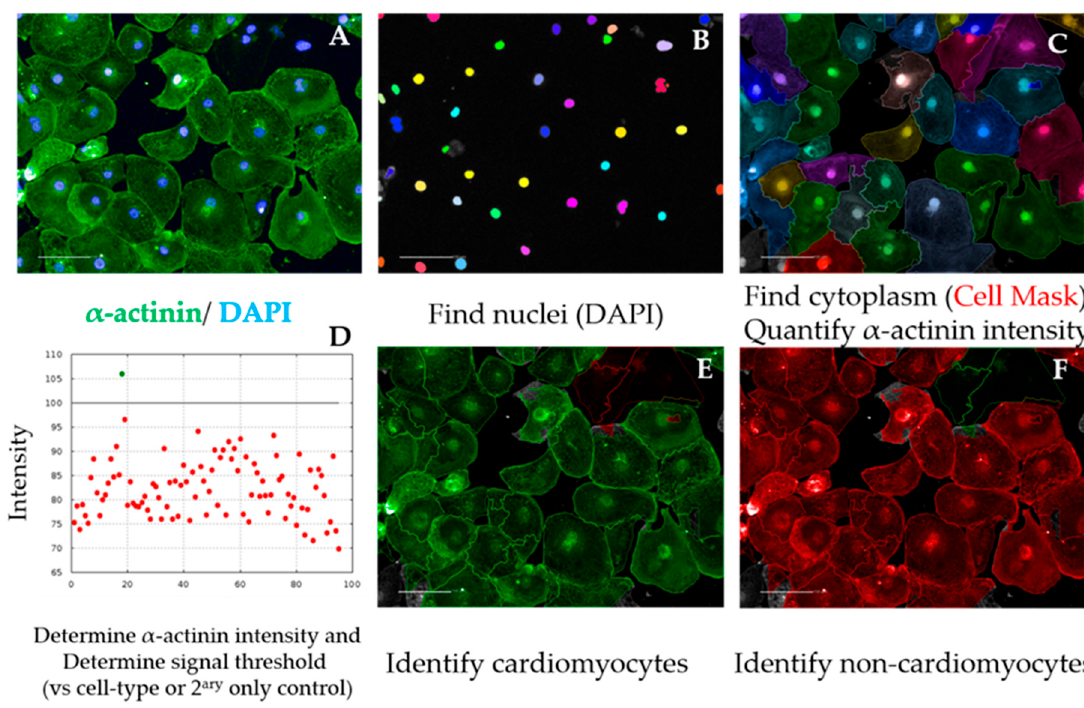
Figure 4. Cardiomyocyte purity analysis sequence. Representative micrographs of image analysis of hPSC-CMs. After inputting the image ( A ), the software excludes debris and cell clumps ( B ) and uses the cell mask staining to define cell cytoplasm ( C ). The α -actinin signal intensity is quantified in the cytoplasm and a positive signal threshold is determined by comparing with cell-type control (e.g., fibroblasts) ( D ), enabling the distinction of cardiomyocytes ( E ) from non-cardiomyocytes ( F ), required to calculate purity. Scale bar = 100 μ m.